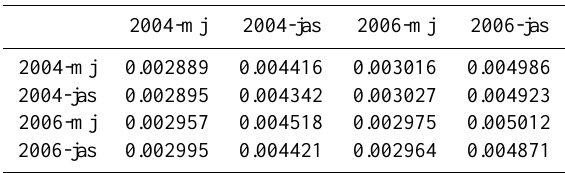
Table 3. Neural network estimation errors on different dataset (columns) versus training set